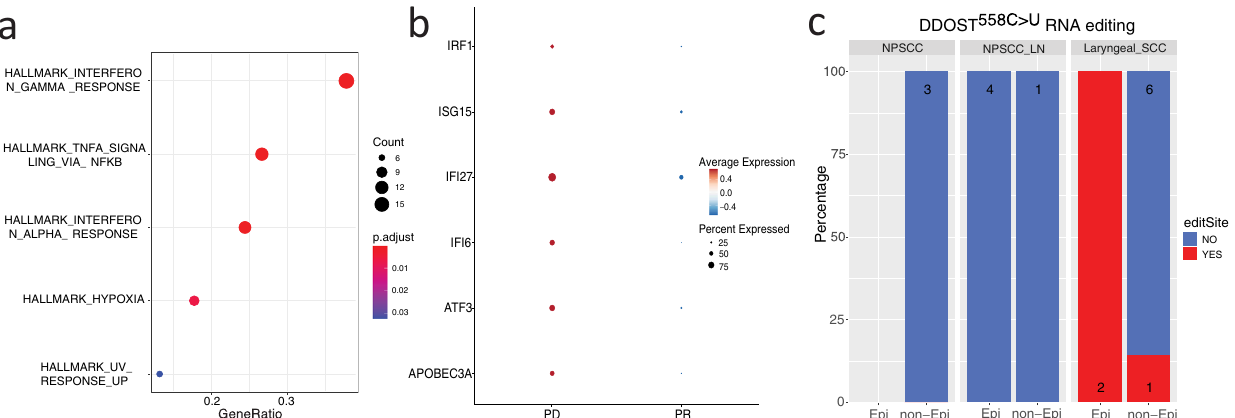
Fig. 4 Upregulated interferon-related genes and elevated APOBEC3A activity in Epithelial 2 cluster in the newly developed laryngeal tumor suggest an interferon-induced APOBEC3A upregulation driving acquired resistance to CPI. a Gene set enrichment analysis of differentially expressed genes (absolute fold change >1.8 and adjusted P value <0.05) in Epithelial 2 cluster in laryngeal SCC vs two regressing lesions. b Dot plot of increased expression of APOBEC3A, ATF3, IFI6, IFI27, ISG15, and IRF1 in Epithelial 2 cluster in laryngeal SCC (PD) vs two regressing lesions (PR). c DDOST 558C>U RNA editing is exclusively observed in laryngeal SCC, mainly in tumor cells. Epi: epithelial cell; non-Epi: non-epithelial